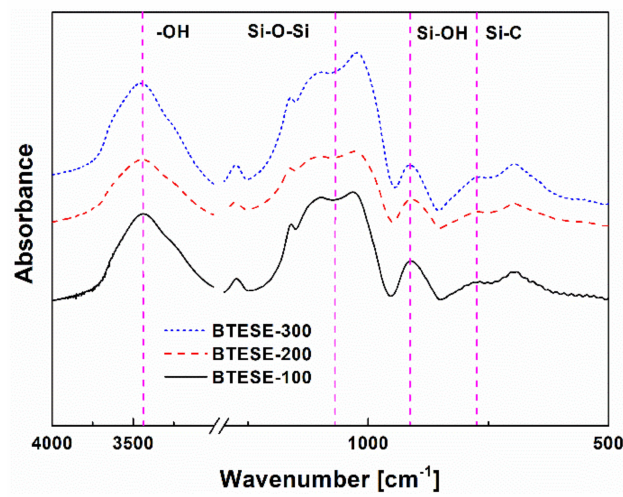
Figure 1. Fourier transform infrared spectrometer (FT-IR) spectra of the 1,2-bis(triethoxylsilyl)ethane (BTESE) films fired at 100, 200, and 300 ◦ C, respectively. Table 1. Water contact angles and FT-IR peak area ratios of Si–OH to Si–O–Si of the BTESE films fabricated at di ff erent temperatures.